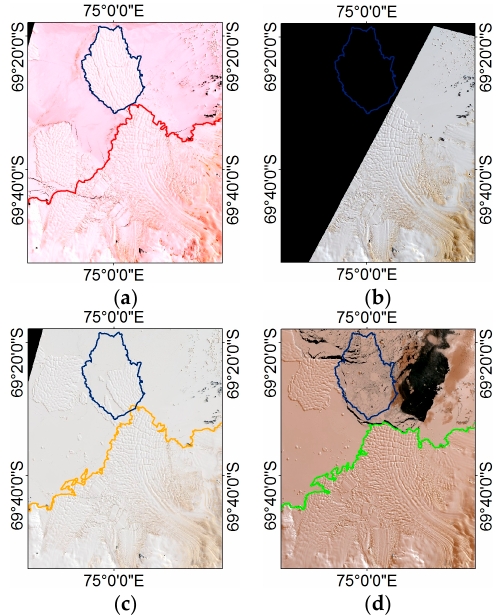
Figure 10. Sequential Landsat series images presenting changes of the iceberg in front of the PRG. The glacier outlines shown in different colors except November 2013. Blue line area presents the outline of the frontal iceberg in January 2013. ( a ) January 2013; ( b ) November 2013; ( c ) November 2014; ( d ) April 2016. Remote Sens. 2018 , 10 , 42